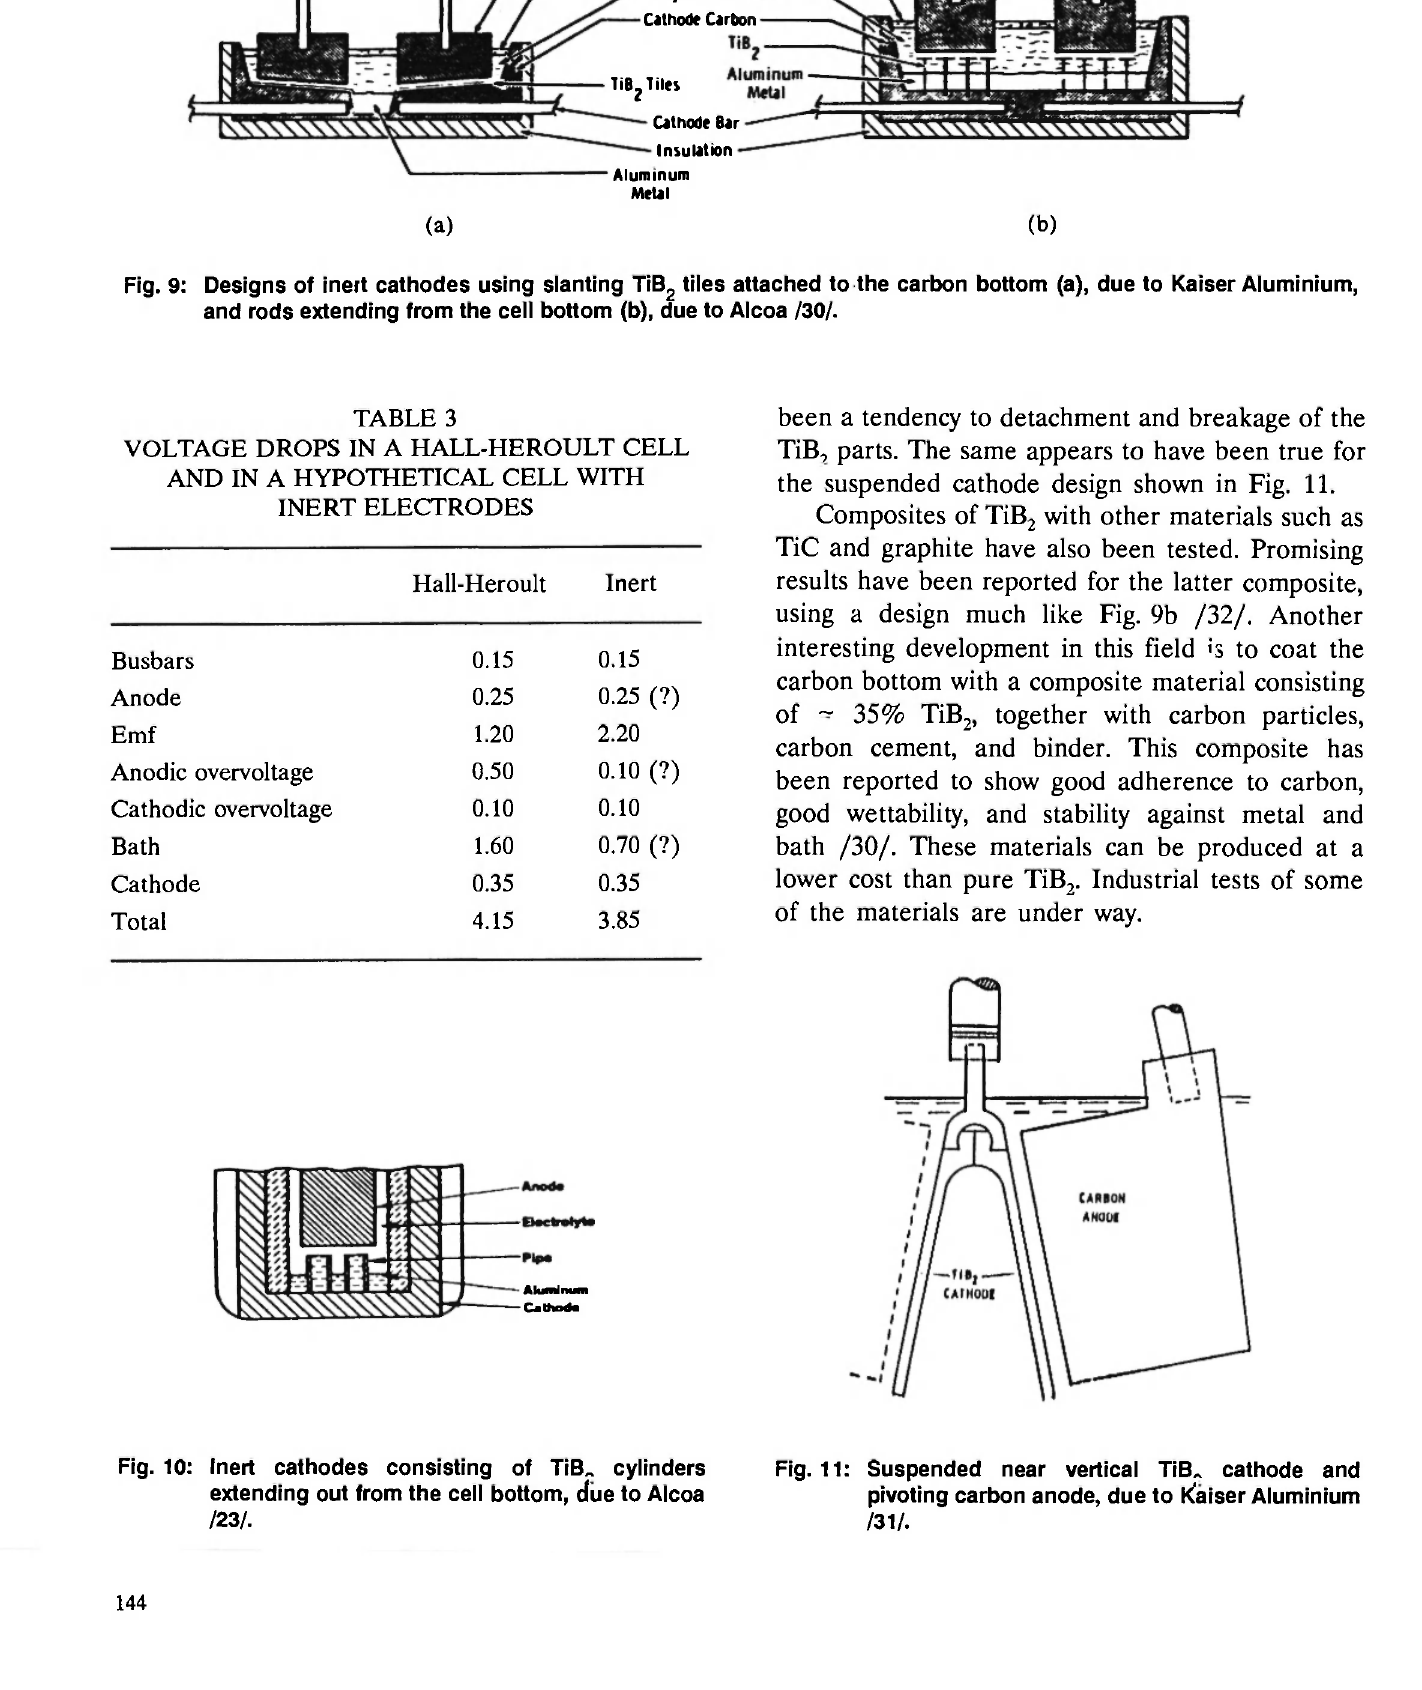
Fig. 10: Inert cathodes consisting of TiB„ cylinders extending out from the cell bottom, due to Alcoa 123/.